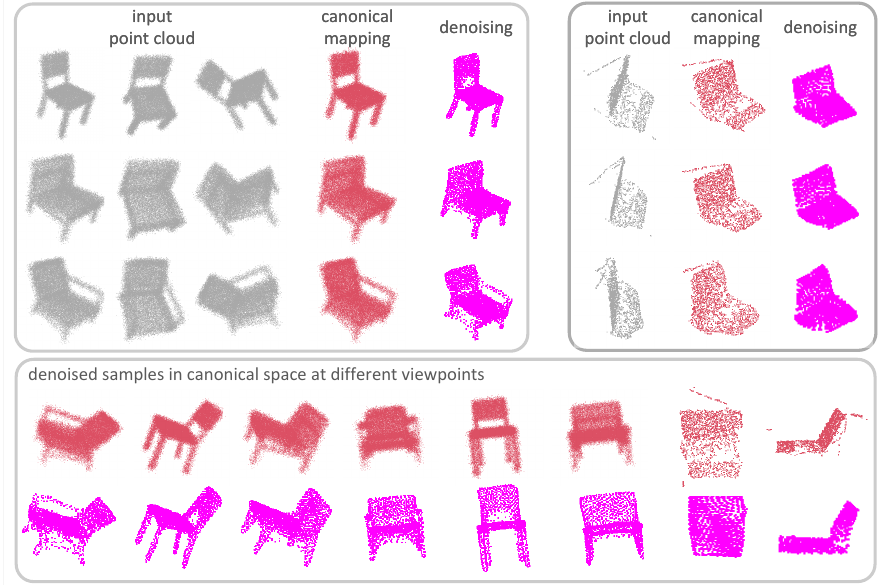
Figure 1. CMD-Net is a self-supervised method that addresses category-level 3D shape denoising through canonicalization: ( top left ) synthetic objects; ( top right ) cluttered real data; and ( bottom ) denoised samples in the canonical space shown at different